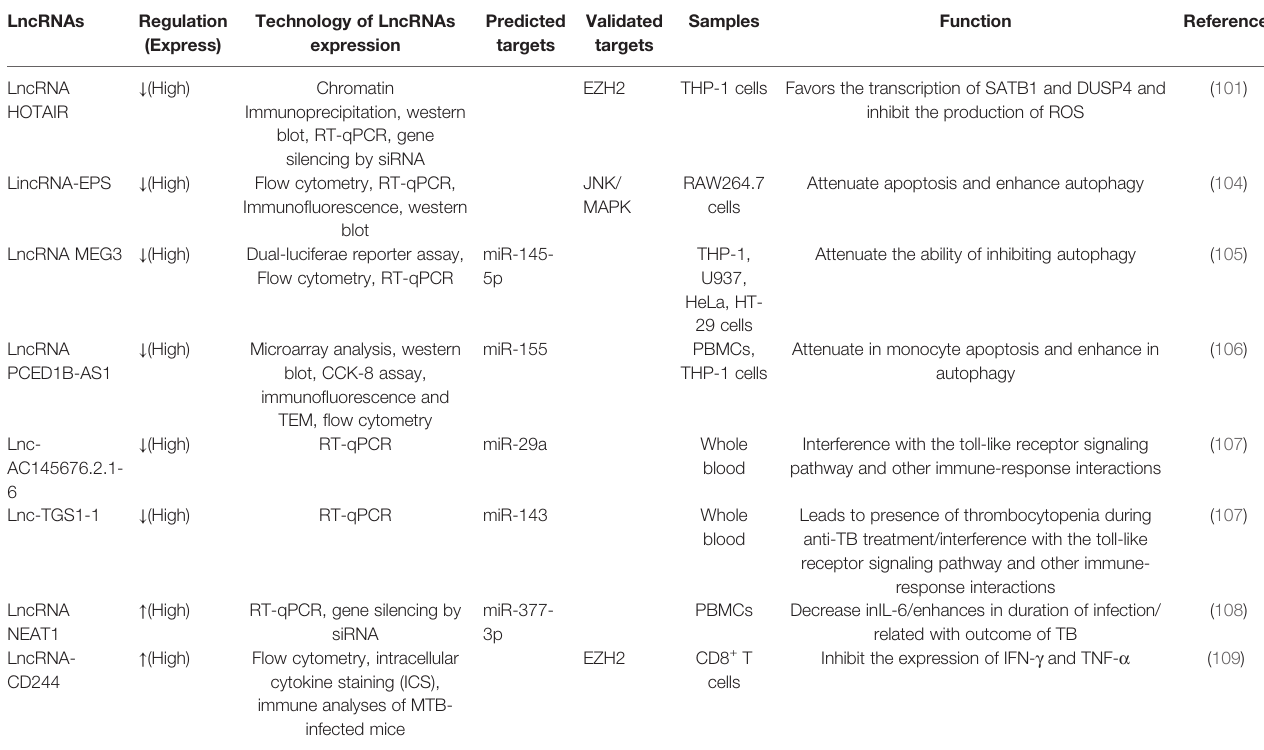
TABLE 5 | The regulatory role of lncRNAs in anti-TB immunity.